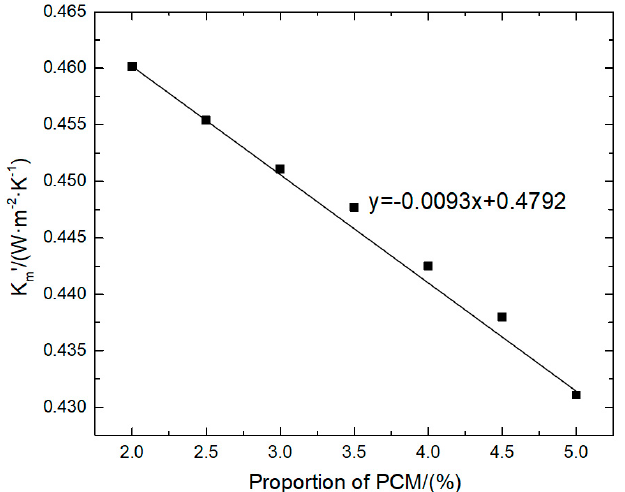
Figure 17. Heat transfer coefficient - proportion of PCM diagram.